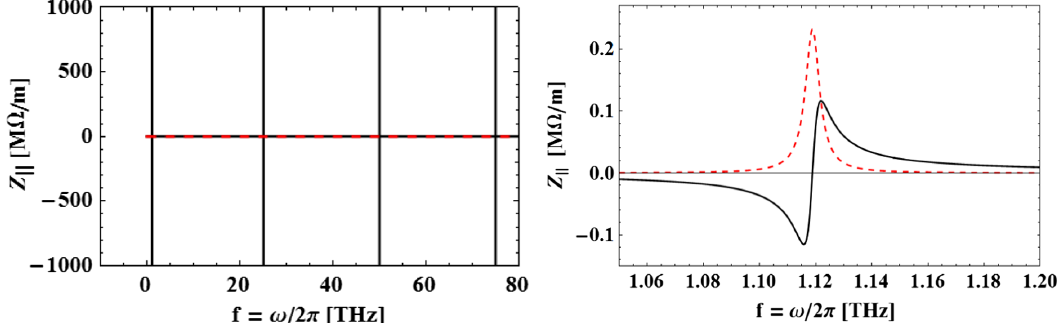
FIG. 13. The real (red, dashed line) and imaginary (black, solid line) components of the longitudinal impedance of the lossless thin dielectric loaded waveguide with a perfectly conducting wall (left) and with finite conducting (copper) walls (right); a 1 ¼ 2 mm, d ¼ 2 μ m, and ε 0 10 1 ¼